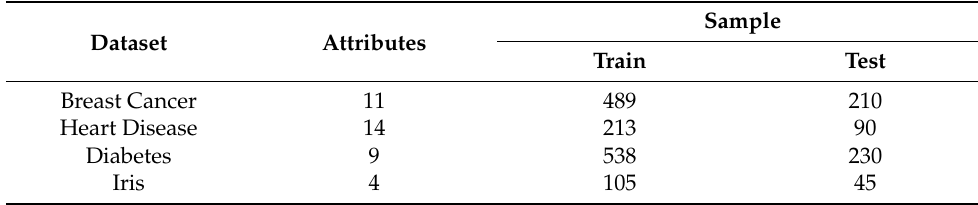
Table 3. Training and testing sets of each